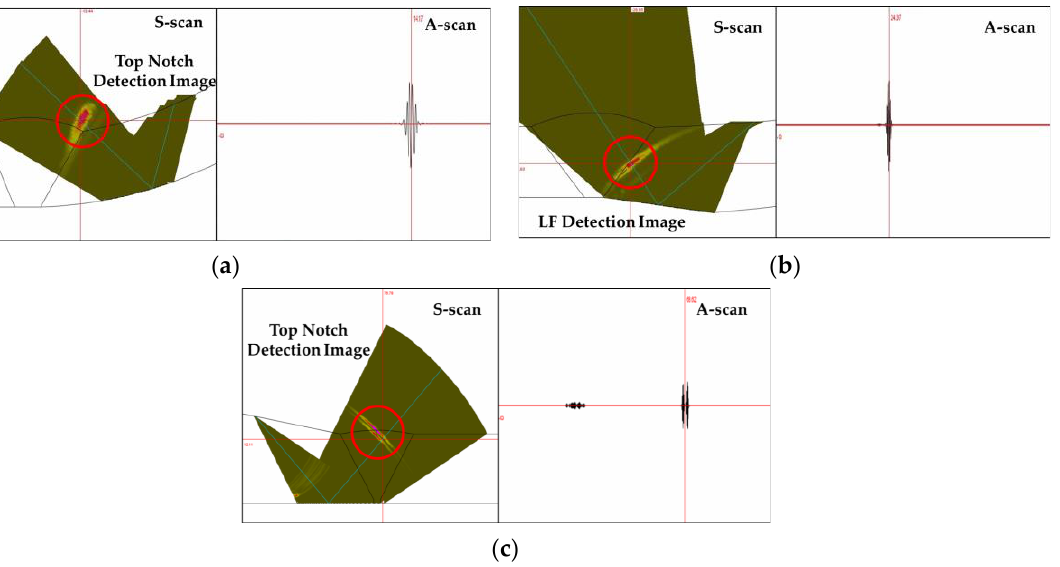
Figure 8. Simulation results from various curvature specimens; ( a ) upper notch of the flange – elbow specimen; ( b ) lack of fusion of the tapered elbow specimen; ( c ) upper notch of the upper-tapered specimen.